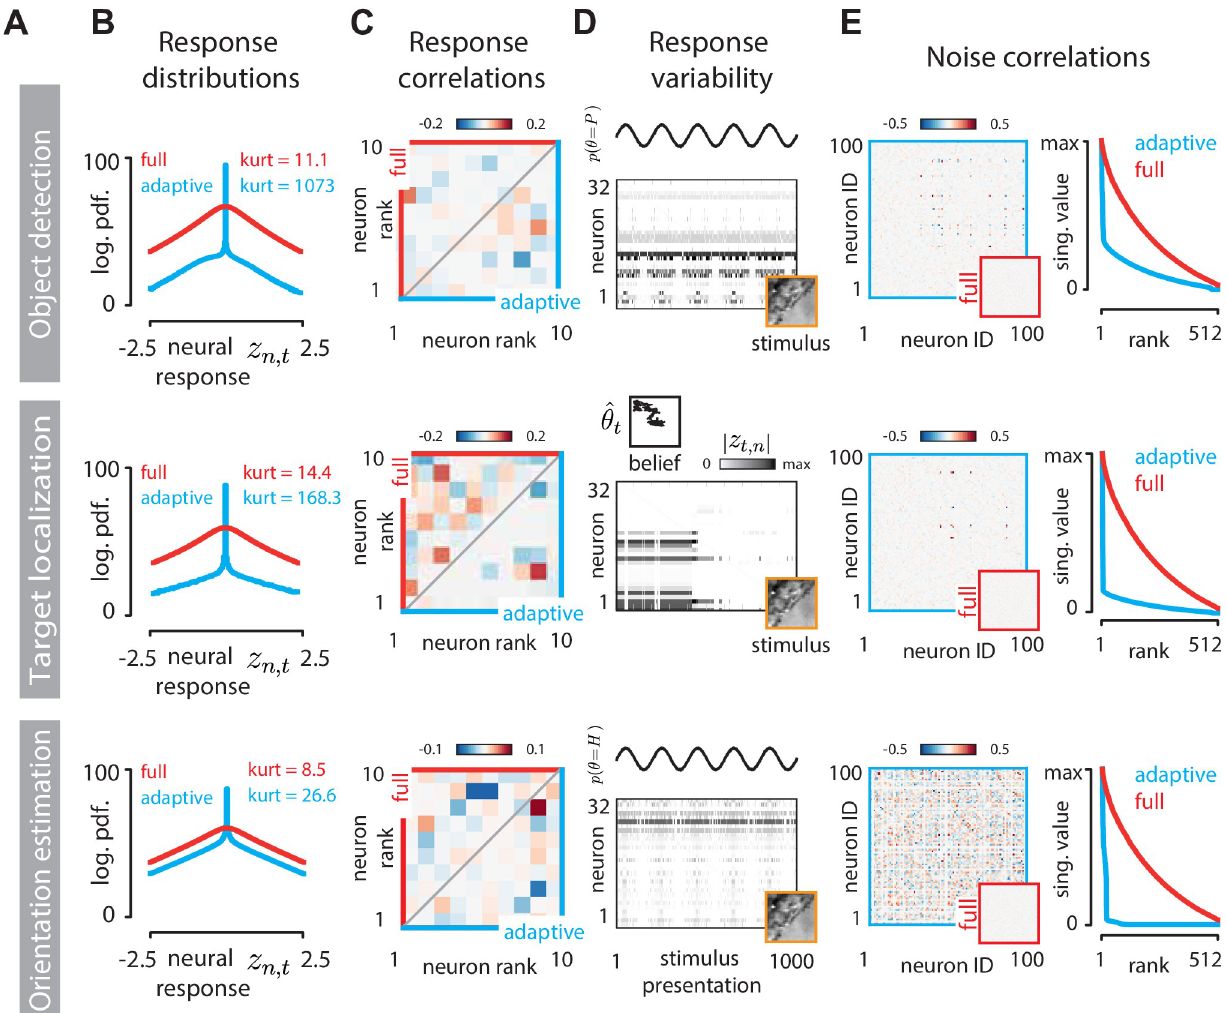
Fig 5. Statistical differences between the adaptive code and the standard sparse code. (A) Rows correspond to inference tasks: object detection (top), target localization (middle), and orientation estimation (bottom). (B) Distributions of neural responses z for the standard sparse code code optimized t , n for image reconstruction (full, red) and the adaptive code (blue); kurtosis as a measure of sparsness is displayed in inset. (C) Pairwise correlations of 10 example neurons whose activity is modulated by the task (different for each task). Correlations were computed over the entire stimulus trajectory used to generate plots in Fig 4. Upper triangle (red) of correlation matrices corresponds to the full code, bottom triangle (blue) to the adaptive code. (D) Belief- induced response variability in the adaptive code. Neural activation (grayscale proportional to | z n , t | 0.5 ) for 32 example neurons chosen separately for each task, exposed to 1,000 presentations of the same stimulus (orange frame). Response variability at fixed stimulus originates from the fluctuations in the internal belief of the perceptual observer (top part of each panel). Here, these fluctuations are simulated as sinusoidal variations in the probability of environmental state (object detection and orientation estimation tasks; top and bottom row, respectively), or a random walk trajectory of the target for the localization task (middle row). (E) Belief-induced noise correlations in the adaptive code. Left column: correlation matrices of the same 100 neurons computed from responses to stimulus presentations displayed in (D). Right column: scaled singular values of correlation matrices of the adaptive code (blue). We compared this spectrum to the standard sparse coding in which a small amount of independent Gaussian noise is added to each neural activation. The normalized singular spectrum of noise correlations of the sparse code (red) is denser compared to that of the adaptive code.